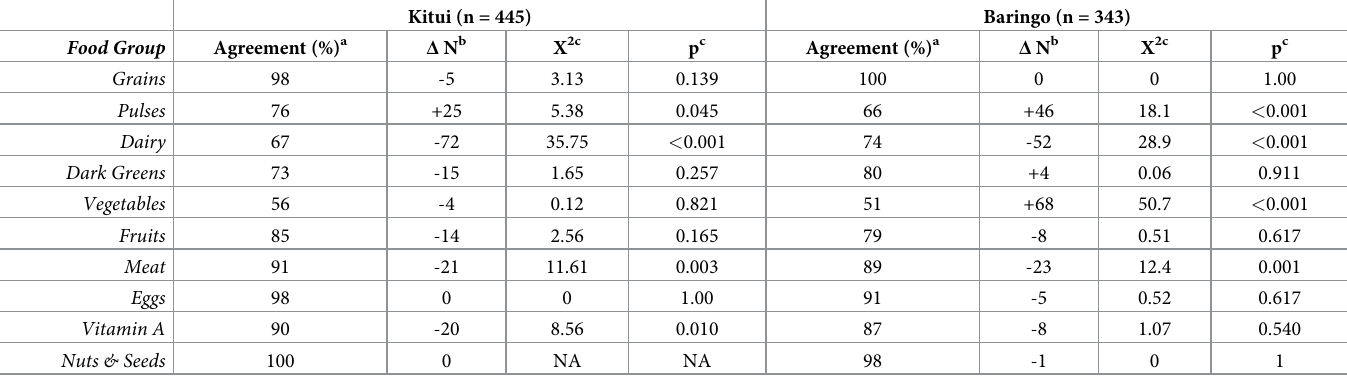
a Percentage of respondents who reported the same consumption (either yes or no) of the food group under CATI and F2F. b The number of respondents who reported consuming that food group under CATI minus the number under F2F. c